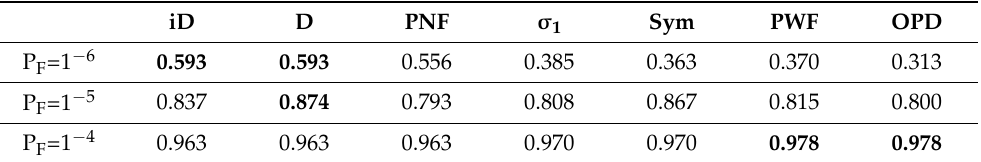
Table 5. Probabilities of detection for dual-polarimetric sea ice. Bold numbers indicate highest P D values.